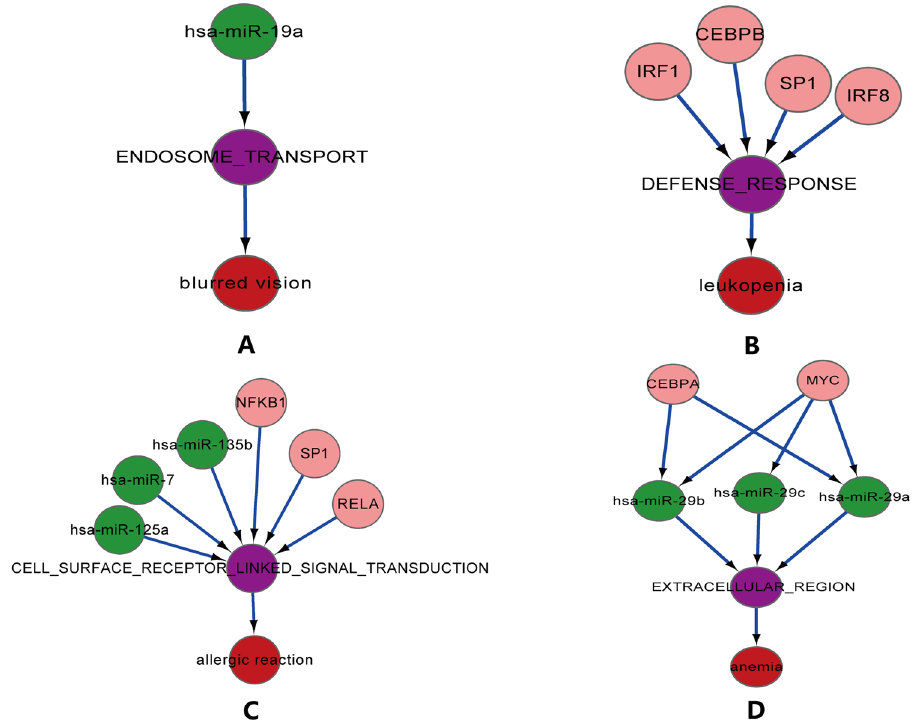
Figure 5. Examples of four regulatory patterns. The red nodes represent side effects; the purple nodes represent gene sets; the green nodes represent miRNAs and the pink nodes represent TFs. ( A ) The first regulatory pattern; ( B ) The second regulatory pattern; ( C ) The third regulatory pattern; ( D ) The last regulatory